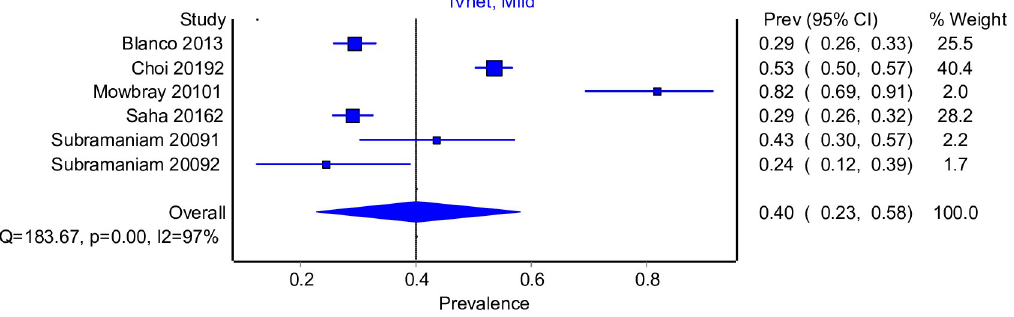
Fig 2. Lifetime treatment seeking for OUD IVhet